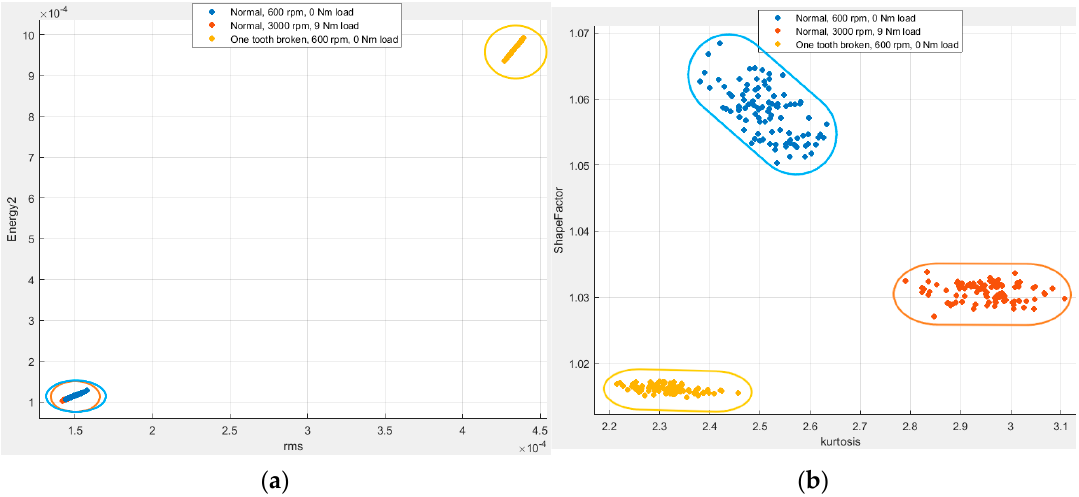
Figure 12. Scatter plot ( a ) for rms and energy-II ( b ) for kurtosis and shape